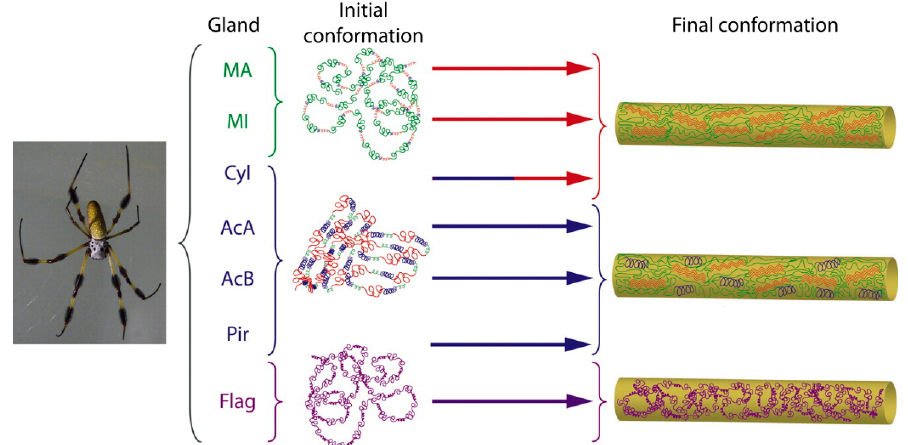
Figure 2. The structural hierarchy of the different spider silks, each secreted from a different gland (where MA = major ampullate, MI = minor ampullate, Cyl = cylindrical, AcA/AcB = derivations of aciniform types, Pir = piriform, and Flag = flagelliform glands). In spider silks, the secondary protein structures of each of the different silks, which themselves are a product of the amino acid sequences of the protein, influence the conformational structure, hence the mechanical performance, of the secreted